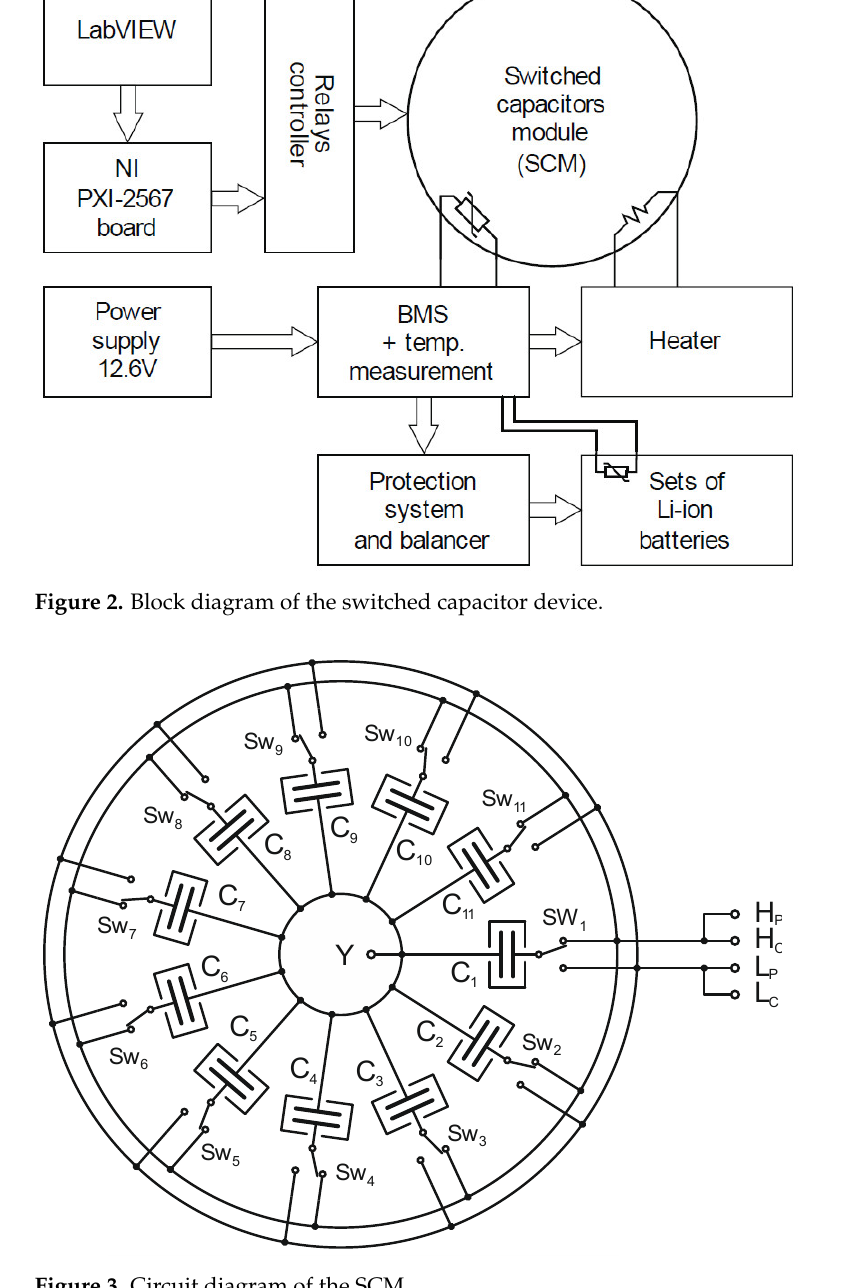
Figure 3. Circuit diagram of the SCM.